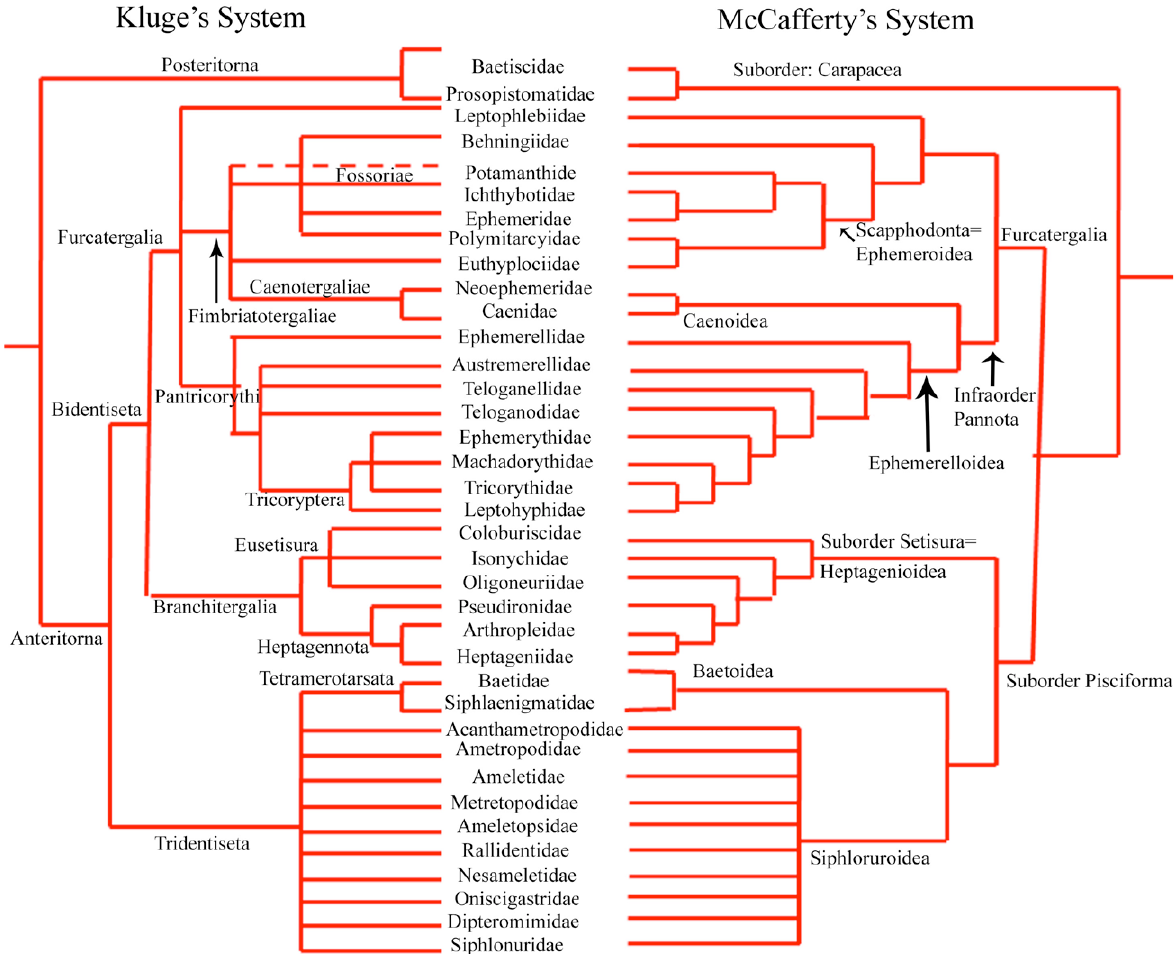
Figure 1. Topological comparison of Kluge’s system and McCafferty’s system of mayfly classification (after Ogden et al.